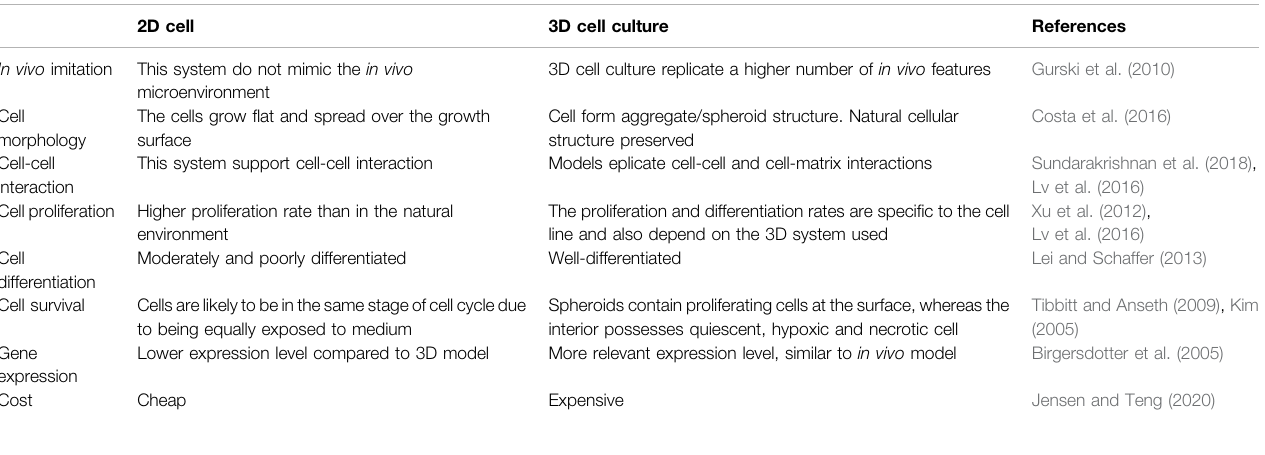
TABLE 1 | Differences between 2D and 3D culture systems in the indicated